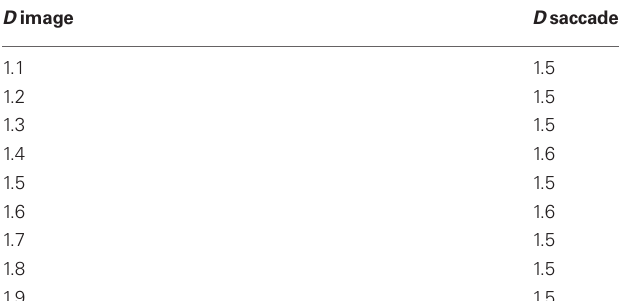
Table 2 | A comparison of the D values of the fractal images being viewed, and the D values of the patterns traced out by the saccades.